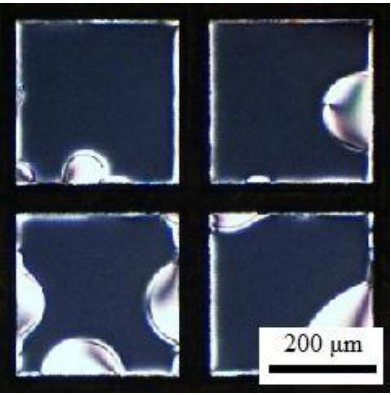
Figure 6. Optical images (crossed polars) of 5CB exposure to a mixture of 20 μM DNA-lipids, 20 μM c-DNA and 5 μM L -DLPC for 1 h.